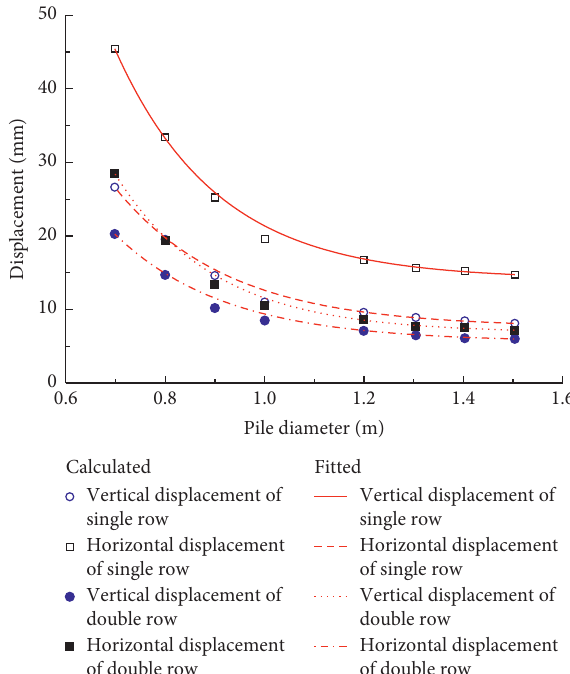
Figure 12: The influence of different pile rows on maximum displacement.